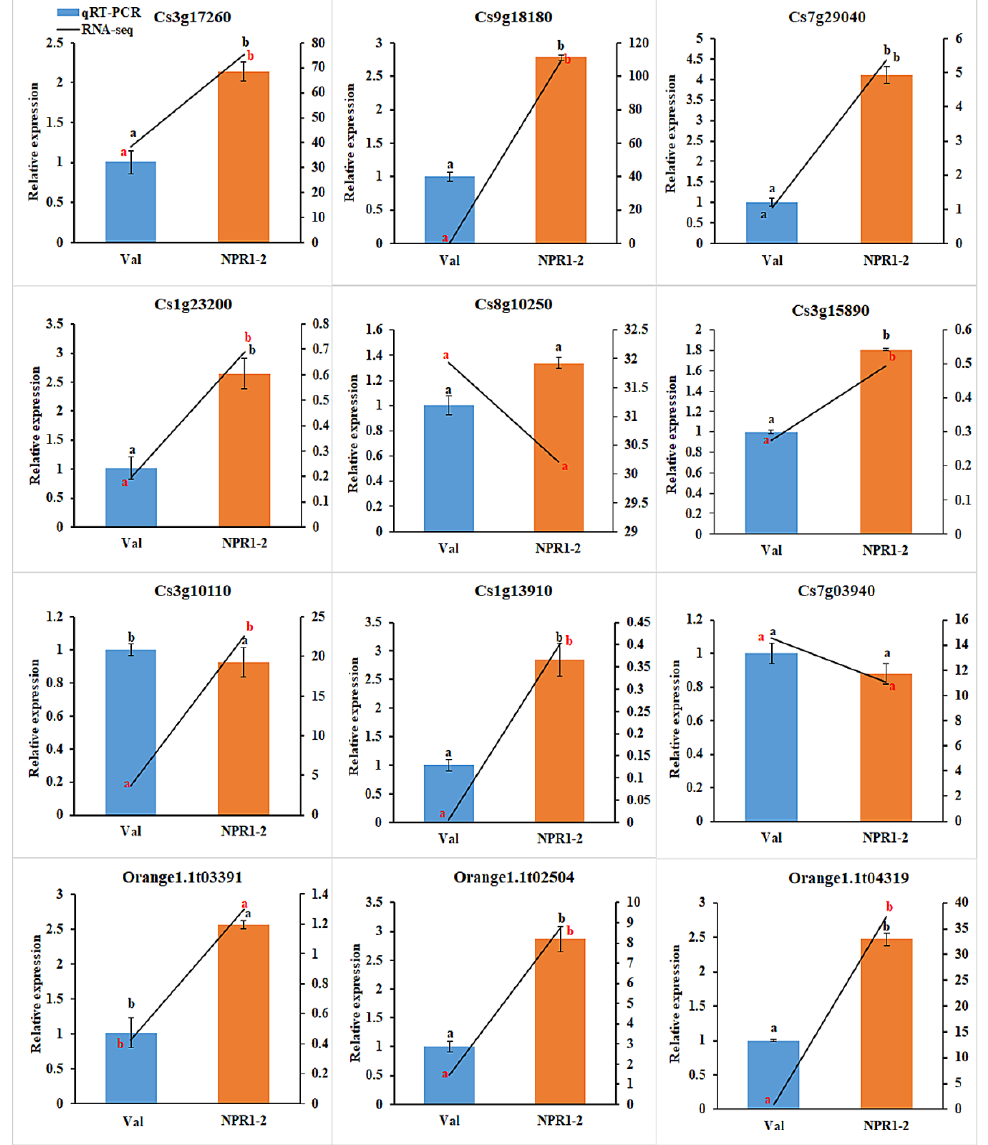
Figure 4. qRT-PCR verification for expression pattern of selected DEGs. The expression levels of DEG candidates in NPR1-2 transgenic line compared to Val control determined by qRT-PCR (2 -ΔΔCt ). Different letters (a, b) represent a significant difference at p ≤ 0.05 using Duncan’s Multiple Range Test and error bars represent SE ( n = 3).